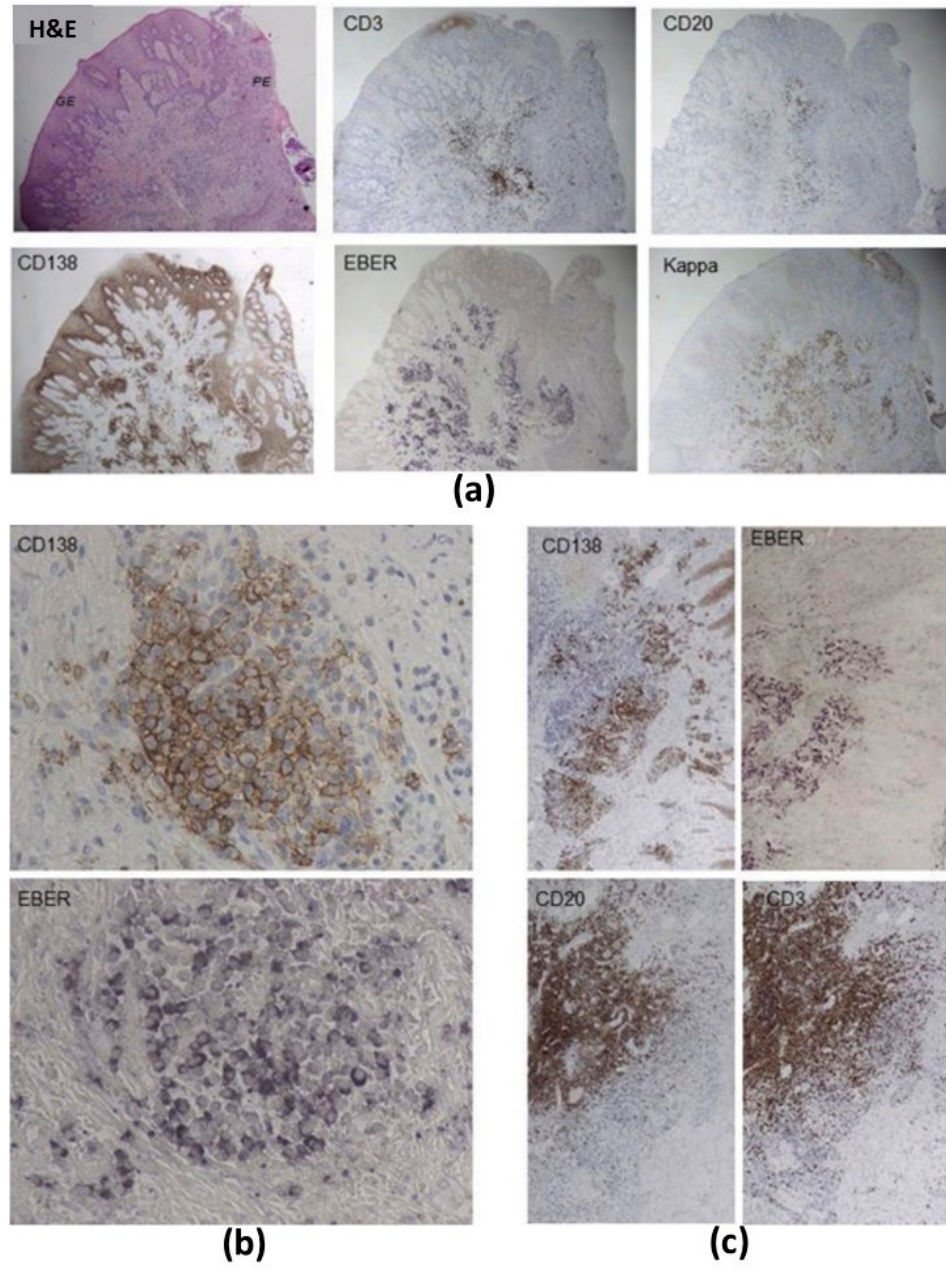
Figure 4. Multiplex chromogenic immunohistochemistry (CIHC) for the detection of T cells (CD3 (cluster of differentiation) marker), B cells (CD20), plasma cells (PCs; CD138) and antibody-producing cells (cytoplasmic kappa light chain) coupled with EBV-encoded RNA in situ hybridization (EBER-ISH) in the gingival tissue specimens of periodontitis patients. Panel ( a ) shows hematoxylin and eosin (H&E) overlapping between CD3, CD20, CD138, EBER and Kappa stainings on a specimen from a periodontitis patient (magnification × 4). Panel ( b ) illustrates a cluster of EBV-infected PCs showing colocalization between EBER and CD138 (magnification × 100). Panel ( c ) is indicative of colocalization between EBV-infected cells (EBER), PCs (CD138), B cells (CD20) and T cells (CD3) (magnification × 10). Reprinted from [62] with permission from Elsevier.